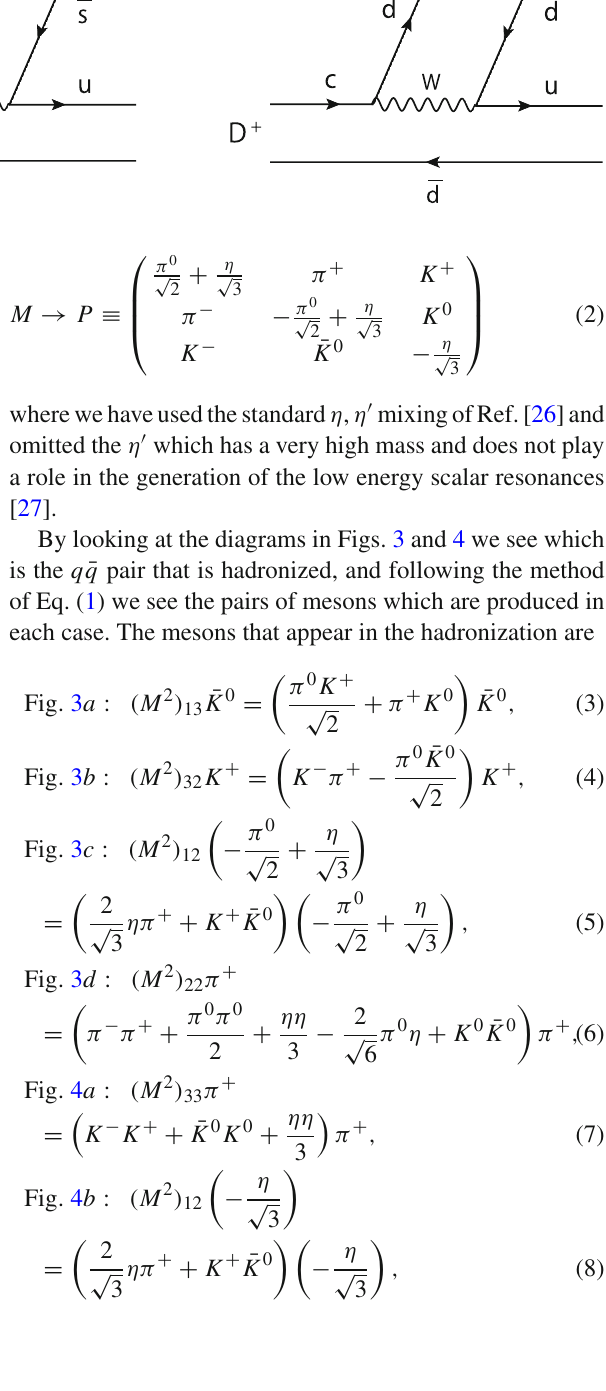
Fig. 2 Diagrams for internal emission at the quark level: a Cabibbo suppressed W ¯ su vertex, b Cabibbo suppressed Wcd